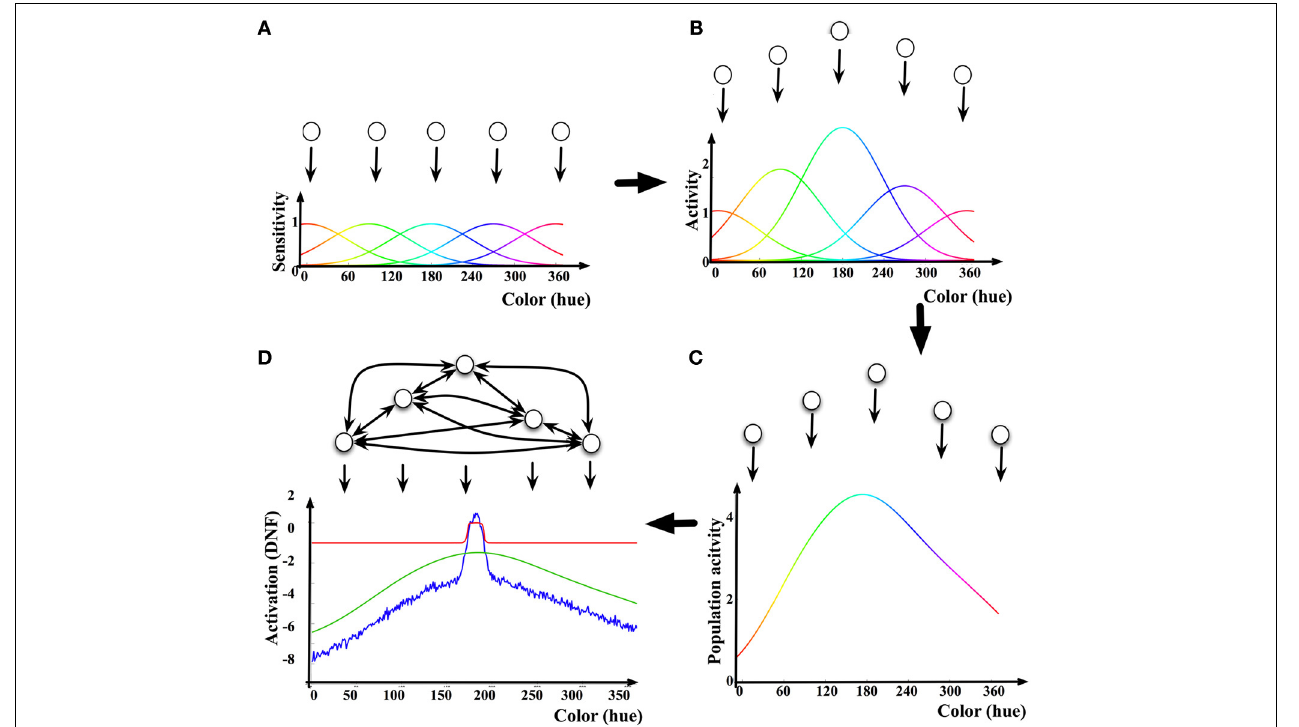
FIGURE 1 | Illustration of the relationship between neuronal activity and a DNF. (A) Five exemplar “neurons” (neuronal populations) and their tuning curves in the color dimension. (B) The tuning curves are scaled by the mean firing rate (activation) of the neurons. (C) By summing the scaled tuning curves, the Dynamic Population Activity [DPA, Bastian et al.